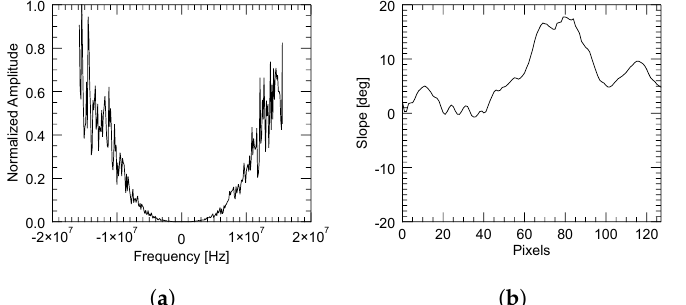
Figure 15. Computed normalized power spectrum ( a ) with the adaptive method in a region with a rapidly variant topography ( b ). A low SNR does not allow a clear identification of the